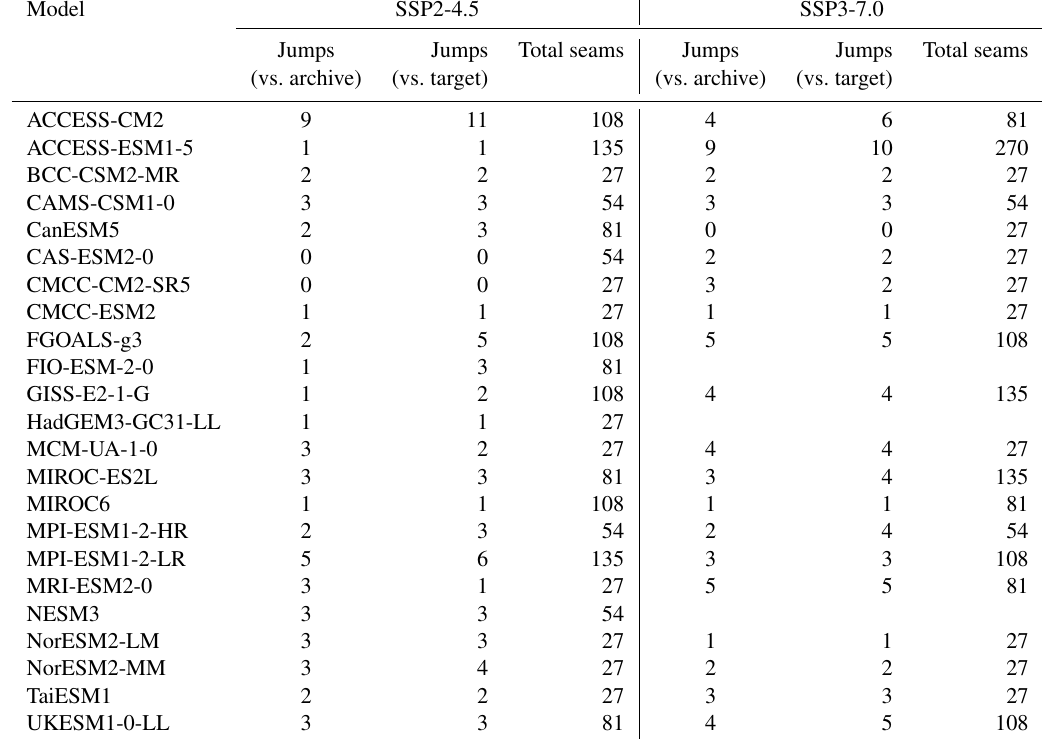
Table 3. For all the models used in our emulation of ESM output under SSP2-4.5 and SSP3-7.0 we report the number of “seams” at which annual GSAT presents a jump that is larger than twice the interannual standard deviation. The latter is computed from either the interannual variations in the archive simulations used in the stitching (in practice, the interannual standard deviations of the stitched trajectories without including the seams in its computation) or the target experiments (the interannual standard deviations of the real series that we are emulating). We also show the total number of seams from which the percentages discussed are